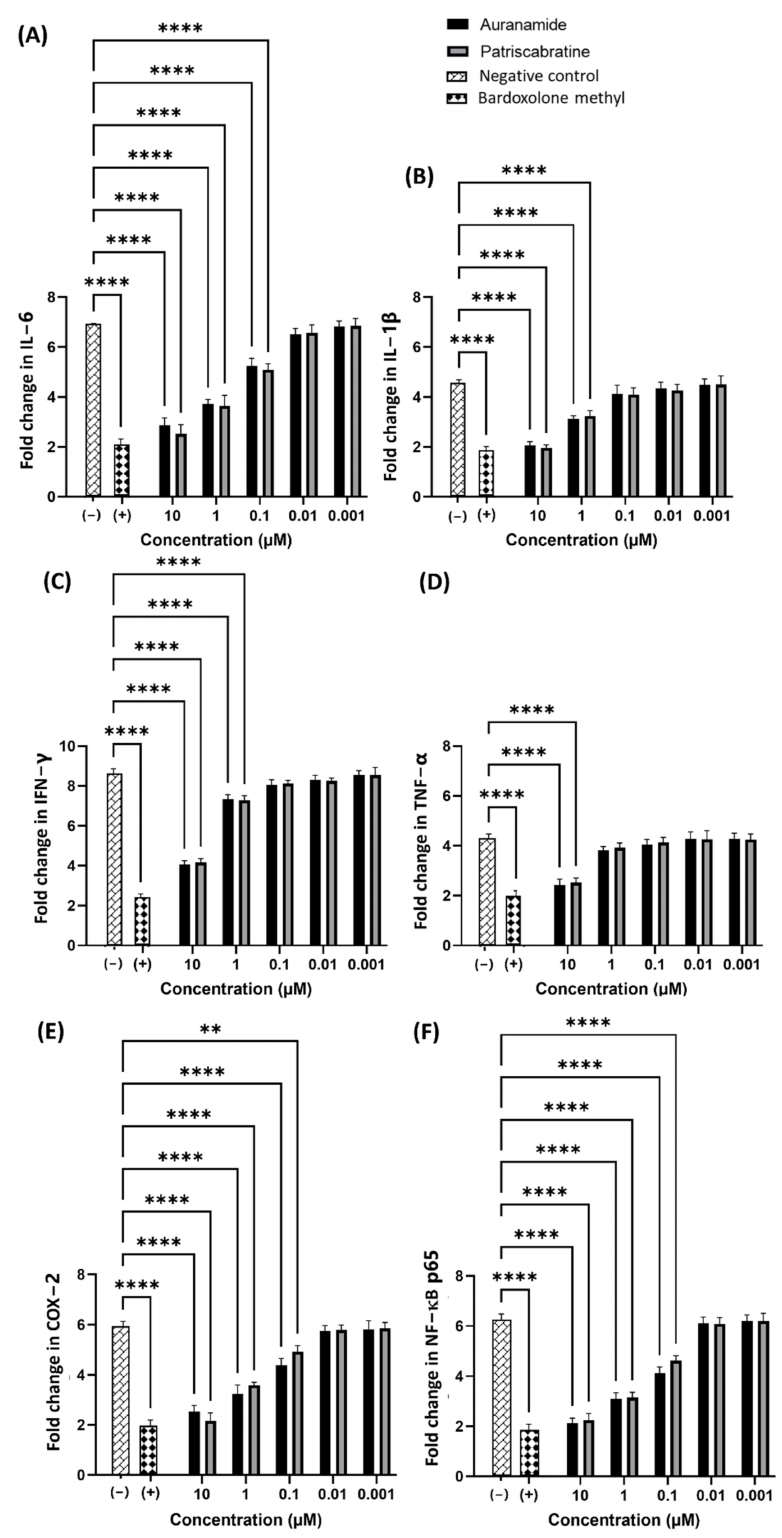
Figure 2. The effect of auranamide and patriscabratine on pro-inflammatory cytokines ( A ) IL-6, ( B ) IL-1 β , ( C ) IFN- γ , and ( D ) TNF- α ; and mediators ( E ) COX-2 and ( F ) NR- κ B. The activity of the test compounds was expressed as fold change. The results are expressed as mean ± SD (n = 3). **, p ≤ 0.01; ****, p ≤ 0.0001 compared to LPS Ec treated cells. The bars without annotation indicate the values are not significant with reference to the negative